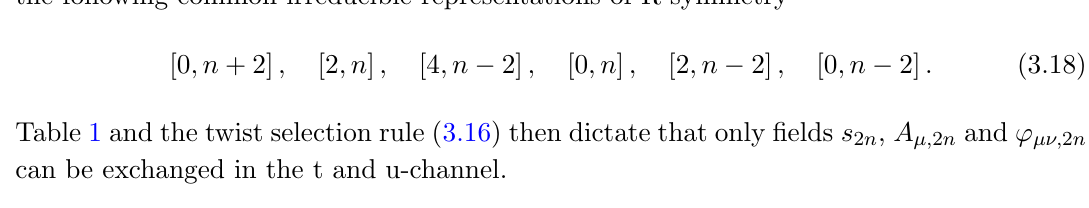
Table 1 and the twist selection rule (3.16) then dictate that only (cid:12)elds s can be exchanged in the t and